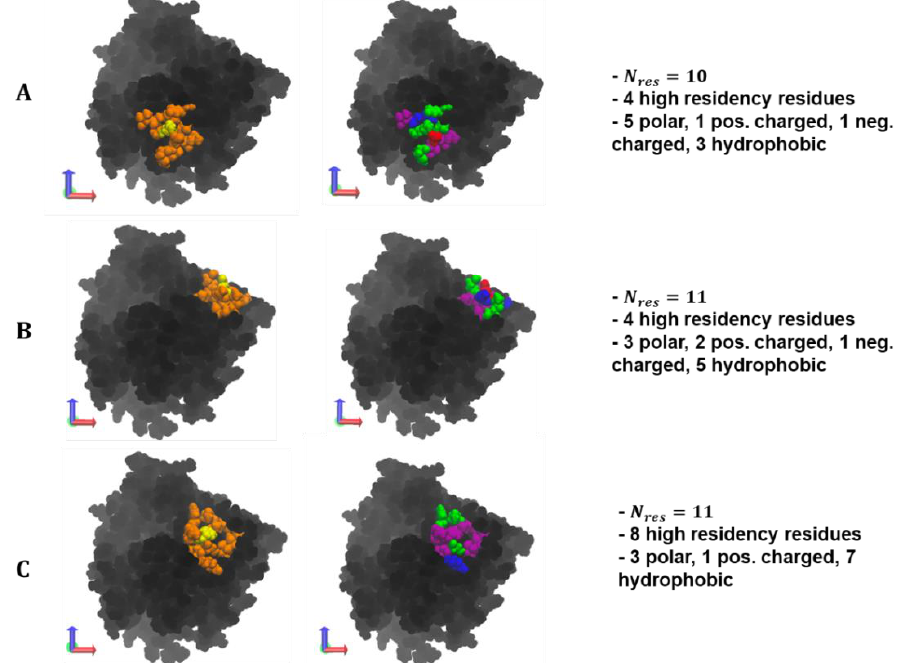
Figure 9. At high extension levels, an individual surface patch with the highest patch overlap percentage with the filtered interface is shown from ( A ) PLGA/ID2S Res OFF phase, ( B ) PEG/ID2S Res ON phase, and ( C ) PLGA-PEG/ID2S Res ON phase. In the first column of images, yellow signifies the central residue from which the patch was generated, and orange indicates residues that were included in the given patch by satisfying the θ cut cutoff requirement of 125 ◦ . Amino acid composition of each patch can be seen in the second column of images, where blue residues are positively charged, red residues are negatively charged, green residues are polar, and purple residues are hydrophobic. N res is the number of residues in the selected